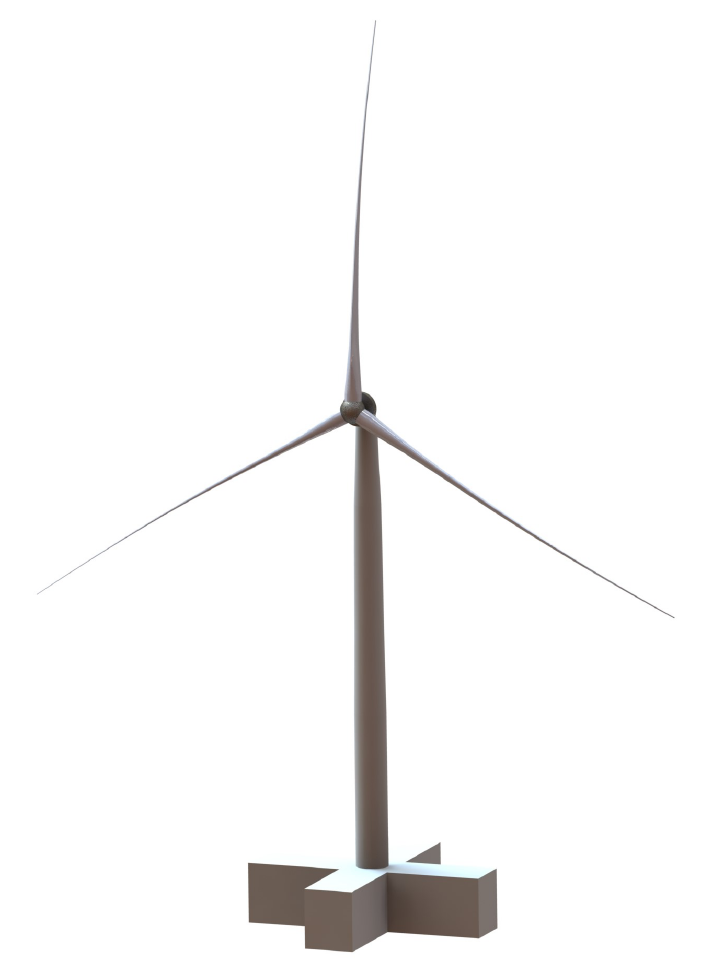
Figure 13. Rendering of the converged platform with the IEA 15-MW